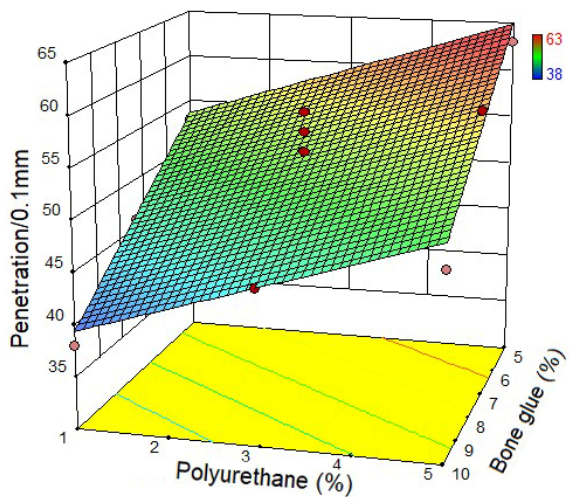
Figure 4. Penetration of the composite modified asphalt (CMA).